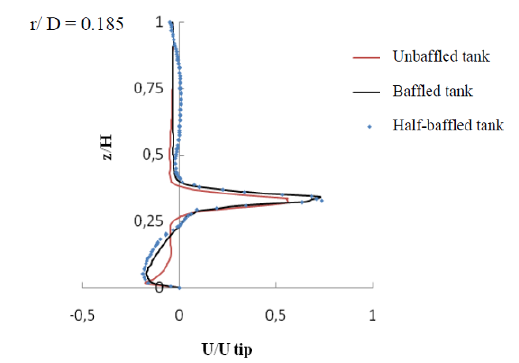
Figure 5. Axial profile of the radial